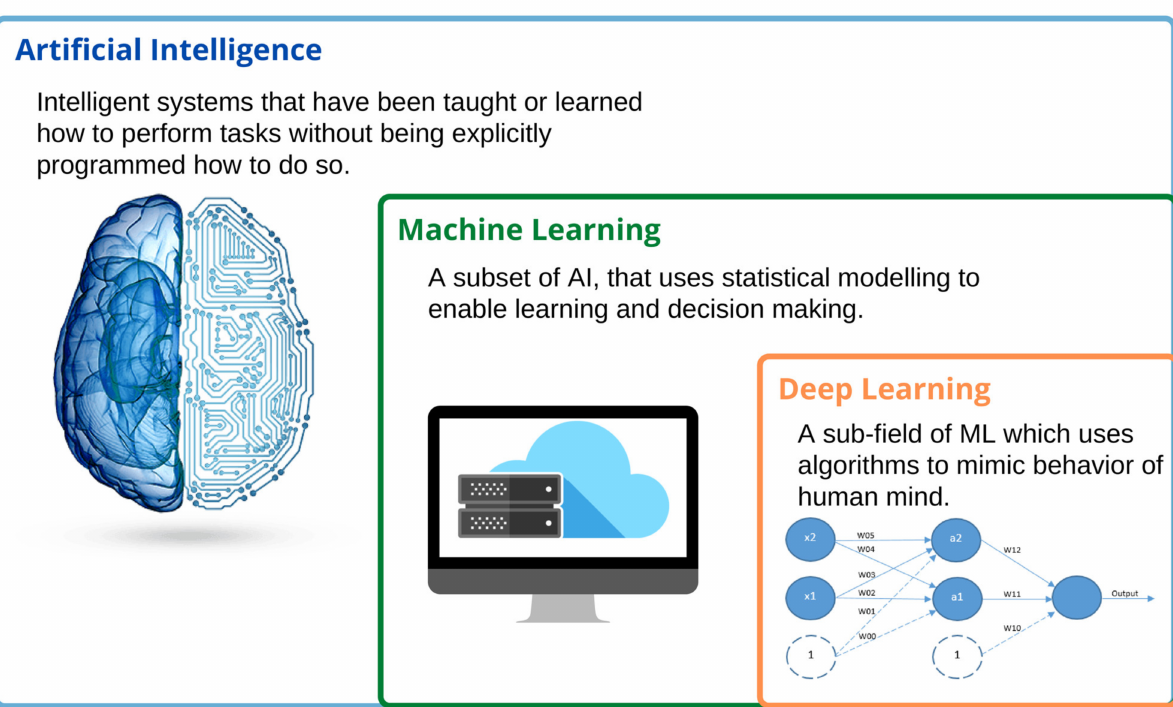
Figure 1. The relationship between artificial intelligence (AI), machine learning (ML), and deep learning